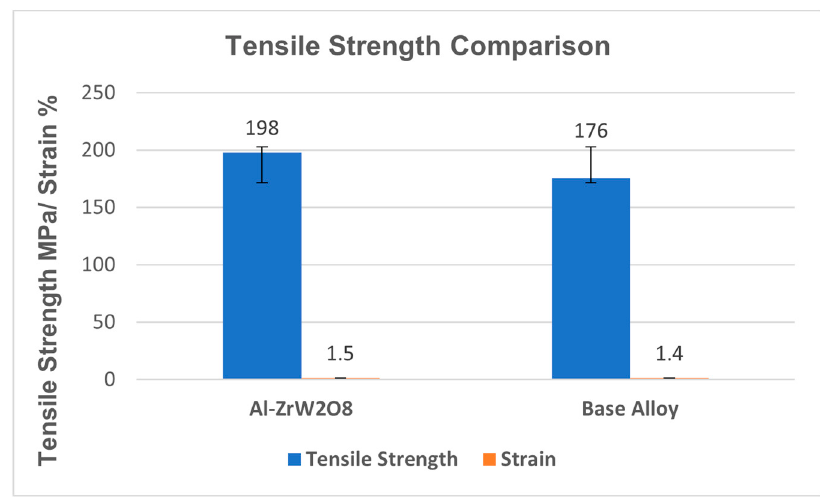
Figure 9. Effect of ceramic on the tensile strength of the base alloy and composite with standard deviation.